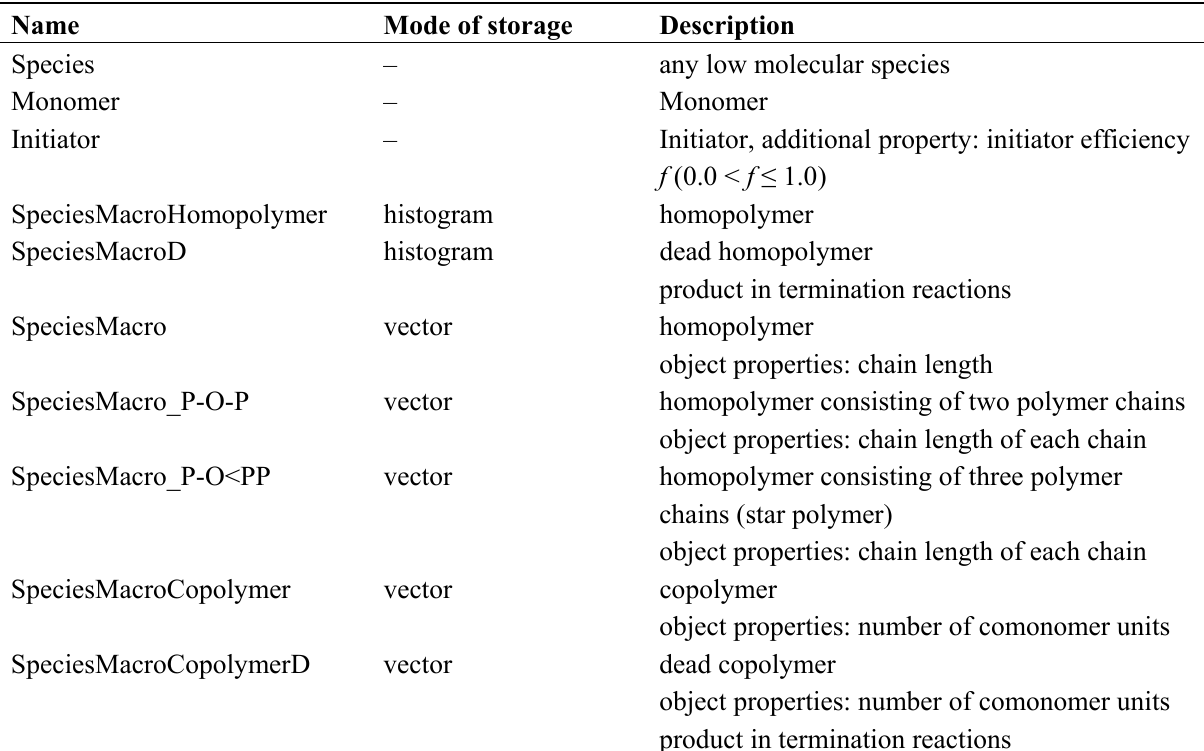
Table 1. Molecular